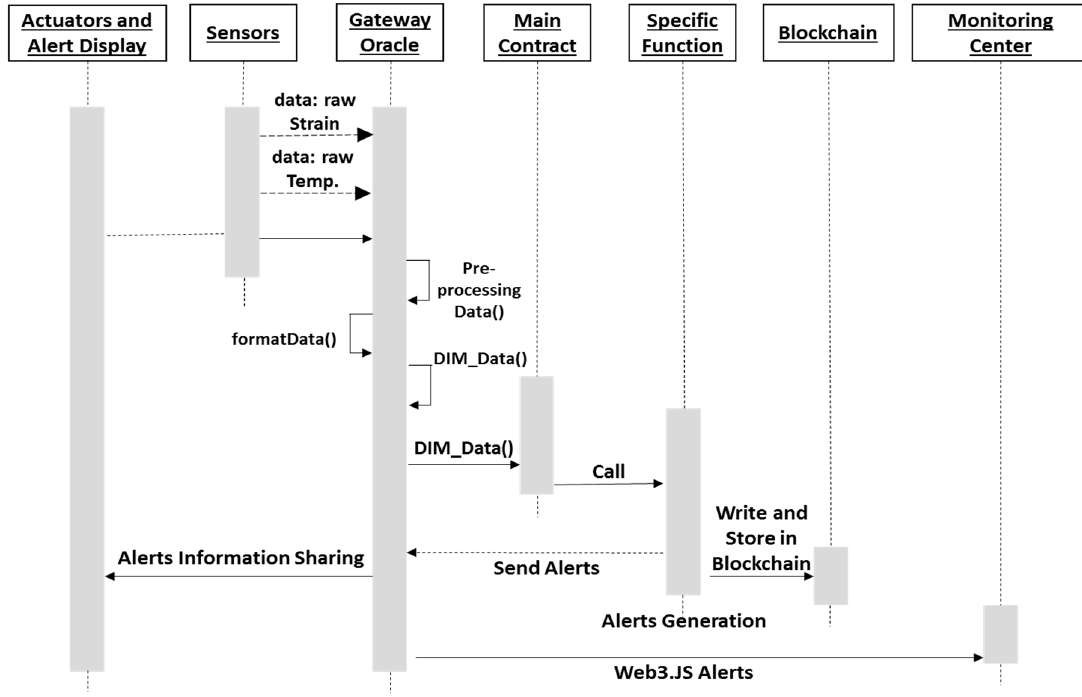
Figure 4. Logical execution flow of proposed system: sensors data is sent to interrogator, and gateway running with Oracle, the gateway implements pre-processingData (), formatData (), and DIM_Data () functions to determine the DIM of the underground mine structure. The DIM determined from sensed data is read by the smart contract to compare with the stored threshold DIM values. Upon meeting the smart contract conditions for the various classes of DIM, the smart contract generates necessary alerts and a transaction will be written to the blockchain.